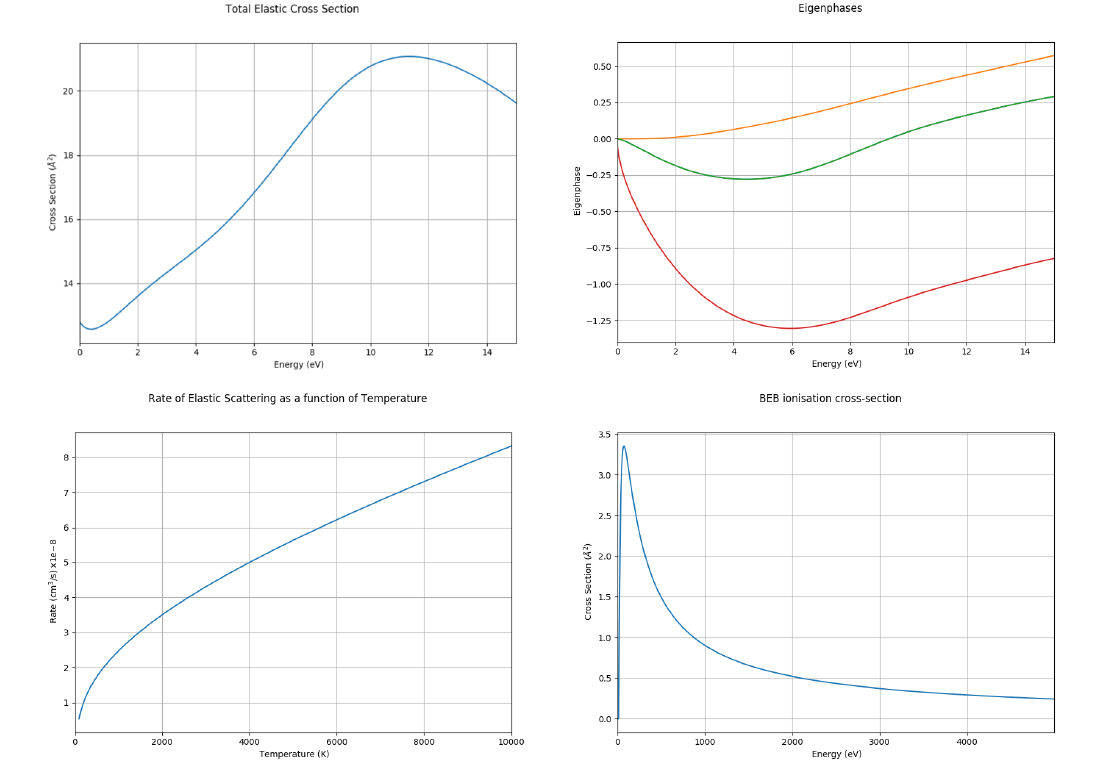
Figure 5. Examples of graphical outputs produced by QEC for a static exchange (SE) calculation on methane showing total cross sections, eigenphase sums, rates and ionization (BEB) cross